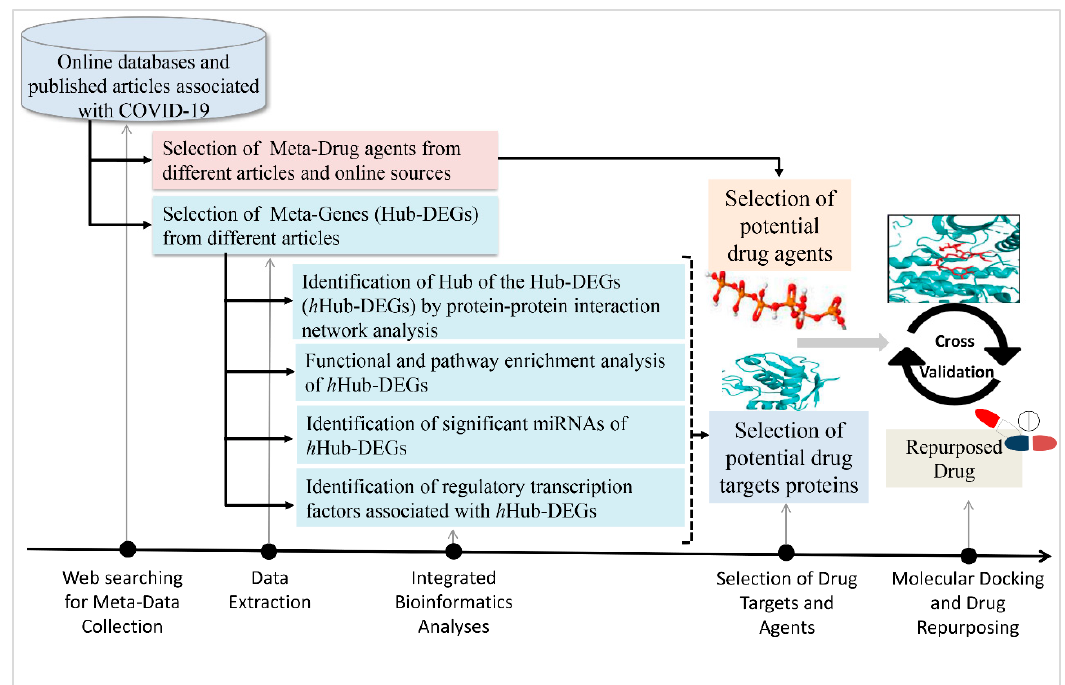
Figure 1. The road map of this